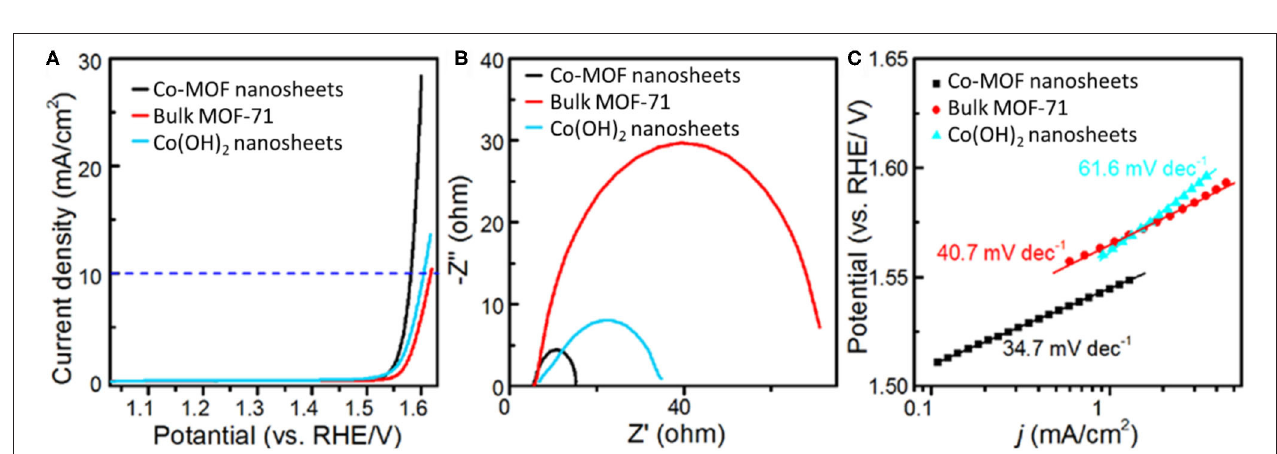
FIGURE 2 | Electrochemical measurements in 1M KOH electrolyte: (A) iR-corrected linear sweep voltammetry (LSV), (B) Nyquist plots, and (C) Tafel plots of Co-MOF nanosheets, bulk MOF-71, and Co(OH) 2 nanosheets.